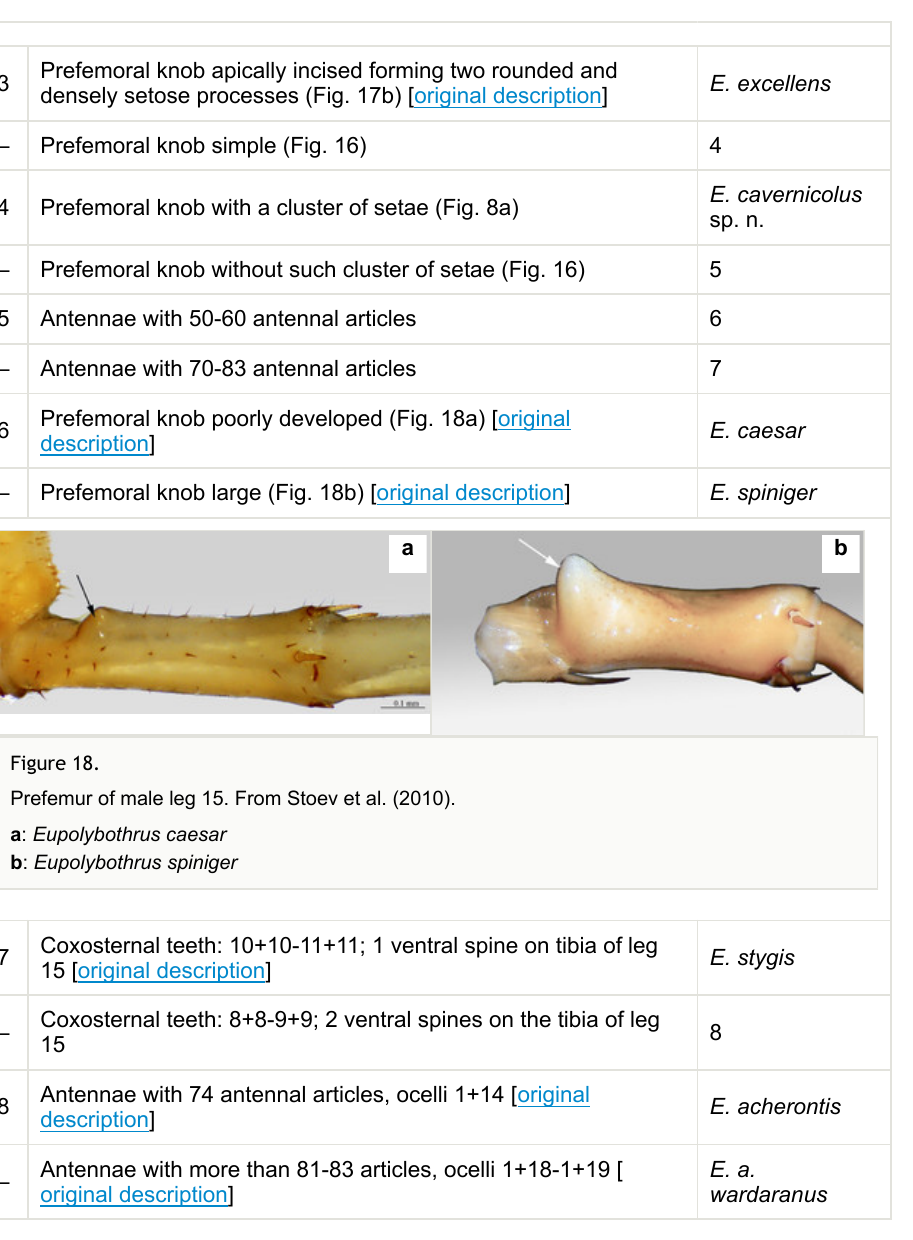
Prefemur of male leg 15. From Stoev et al.